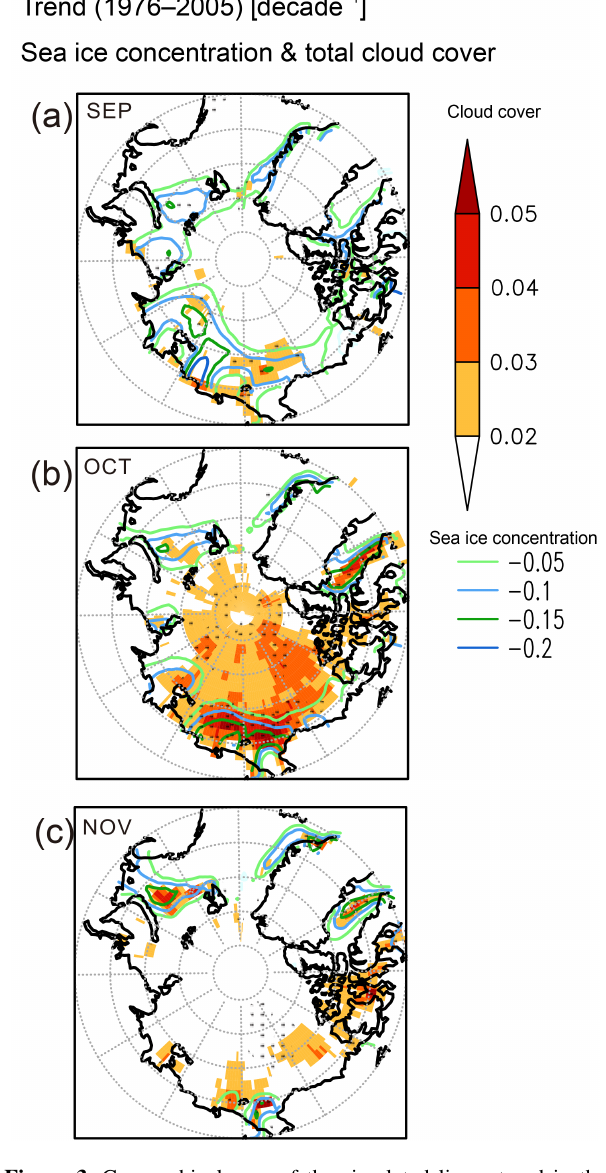
Figure 3. Geographical map of the simulated linear trend in the total cloud cover (shaded) and sea ice concentration (contours) in (a) September, (b) October, and (c) November during the period 1976–2005. The units are decade − 1 . Dots indicate that the linear trend is not zero at the 95% significance